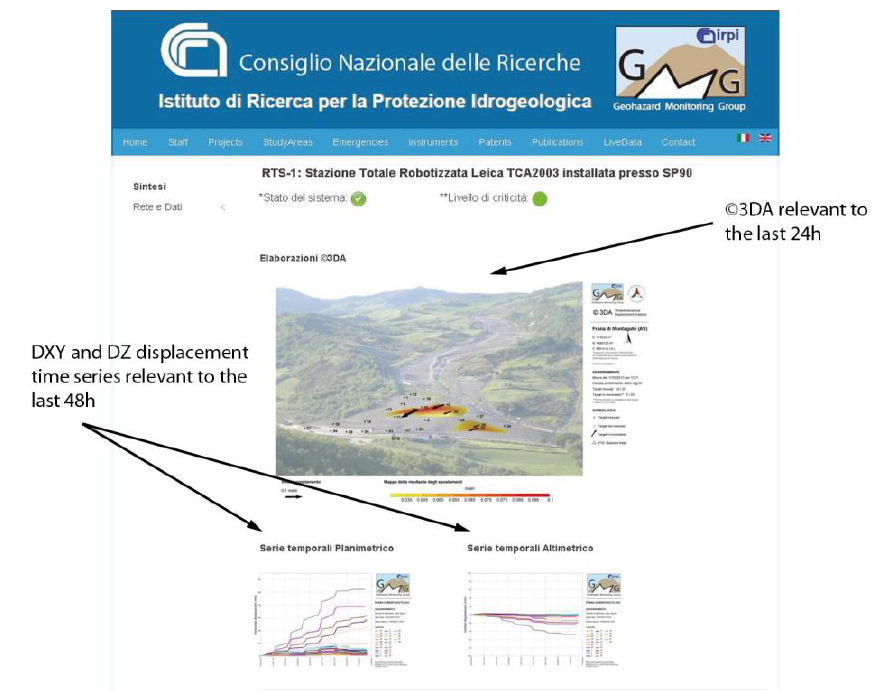
Figure 10. Example of the webpage dedicated to the near-real-time dissemination of monitoring data relevant to the Montaguto